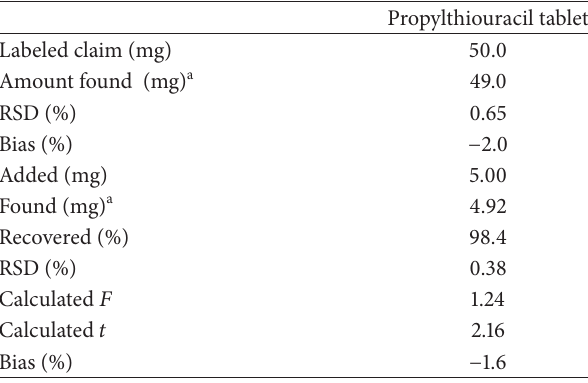
Table 4: Results of the assay and the recovery test of 2TU in pharmaceutical preparations using square wave